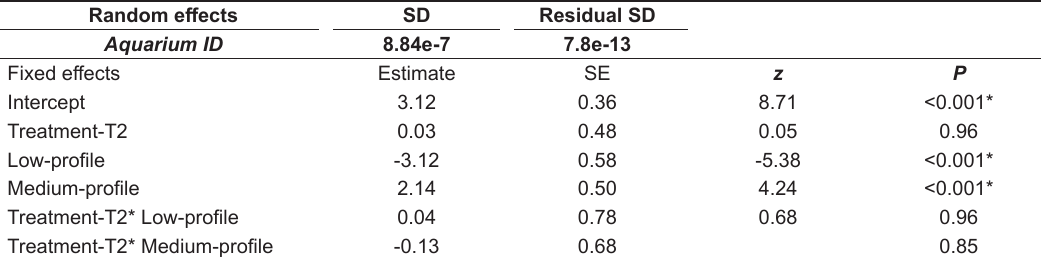
*indicate significant values (p <